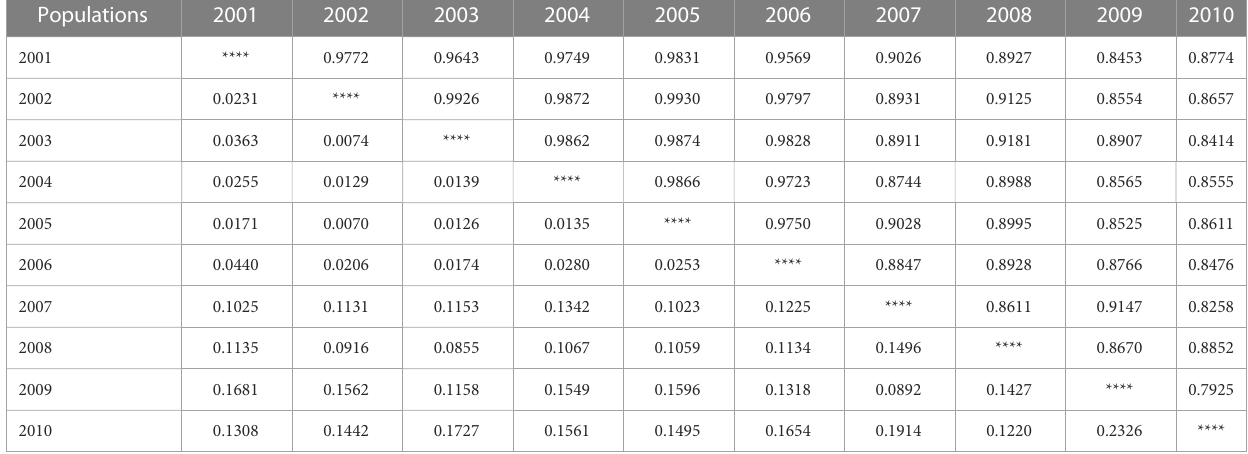
TABLE 6 Nei ’ s unbiased measures of genetic distances and genetic identities between